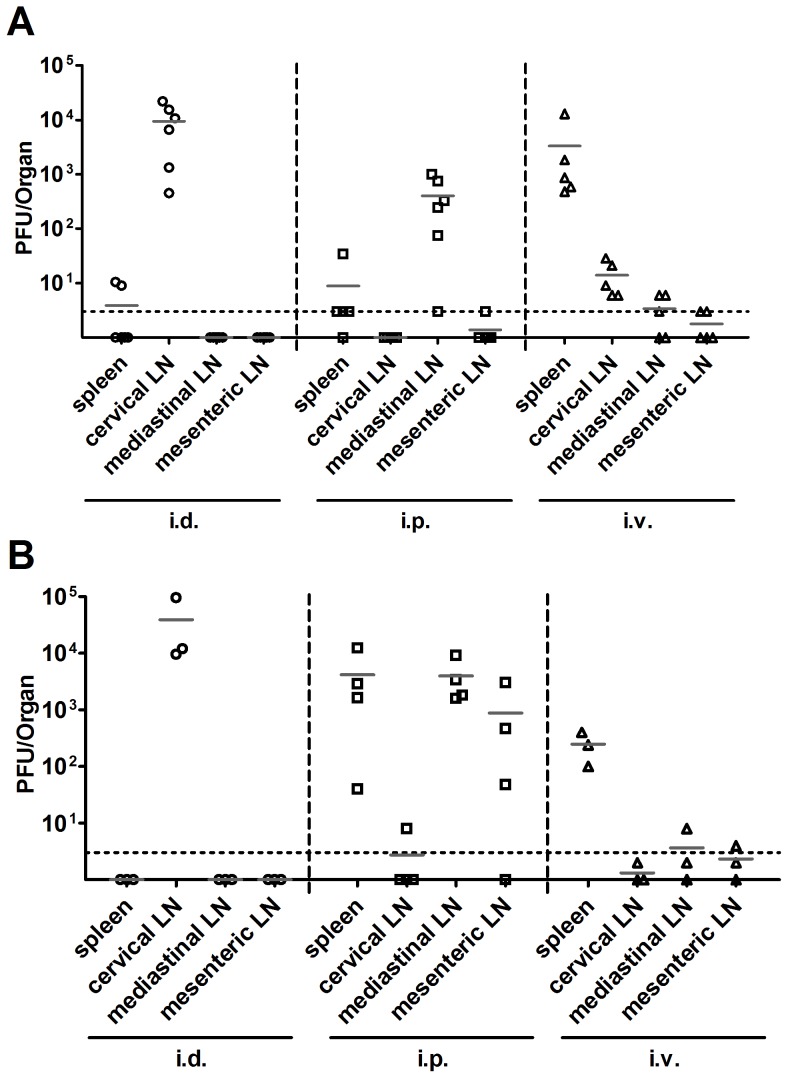
VACV spreads more widely after i.v. or i.p. infection.C57BL/6 mice were infected with 1×106 PFU of VACV WR by i.v., i.p. or i.d. injection. At 6 (A) or 24 (B) hours after infection, spleen and lymph nodes were collected and infectious virus measured by plaque assay. Titers from each organ are plotted with the average for each group shown by a grey bar. The dotted line represents the limit of detection (3 PFU/Organ).